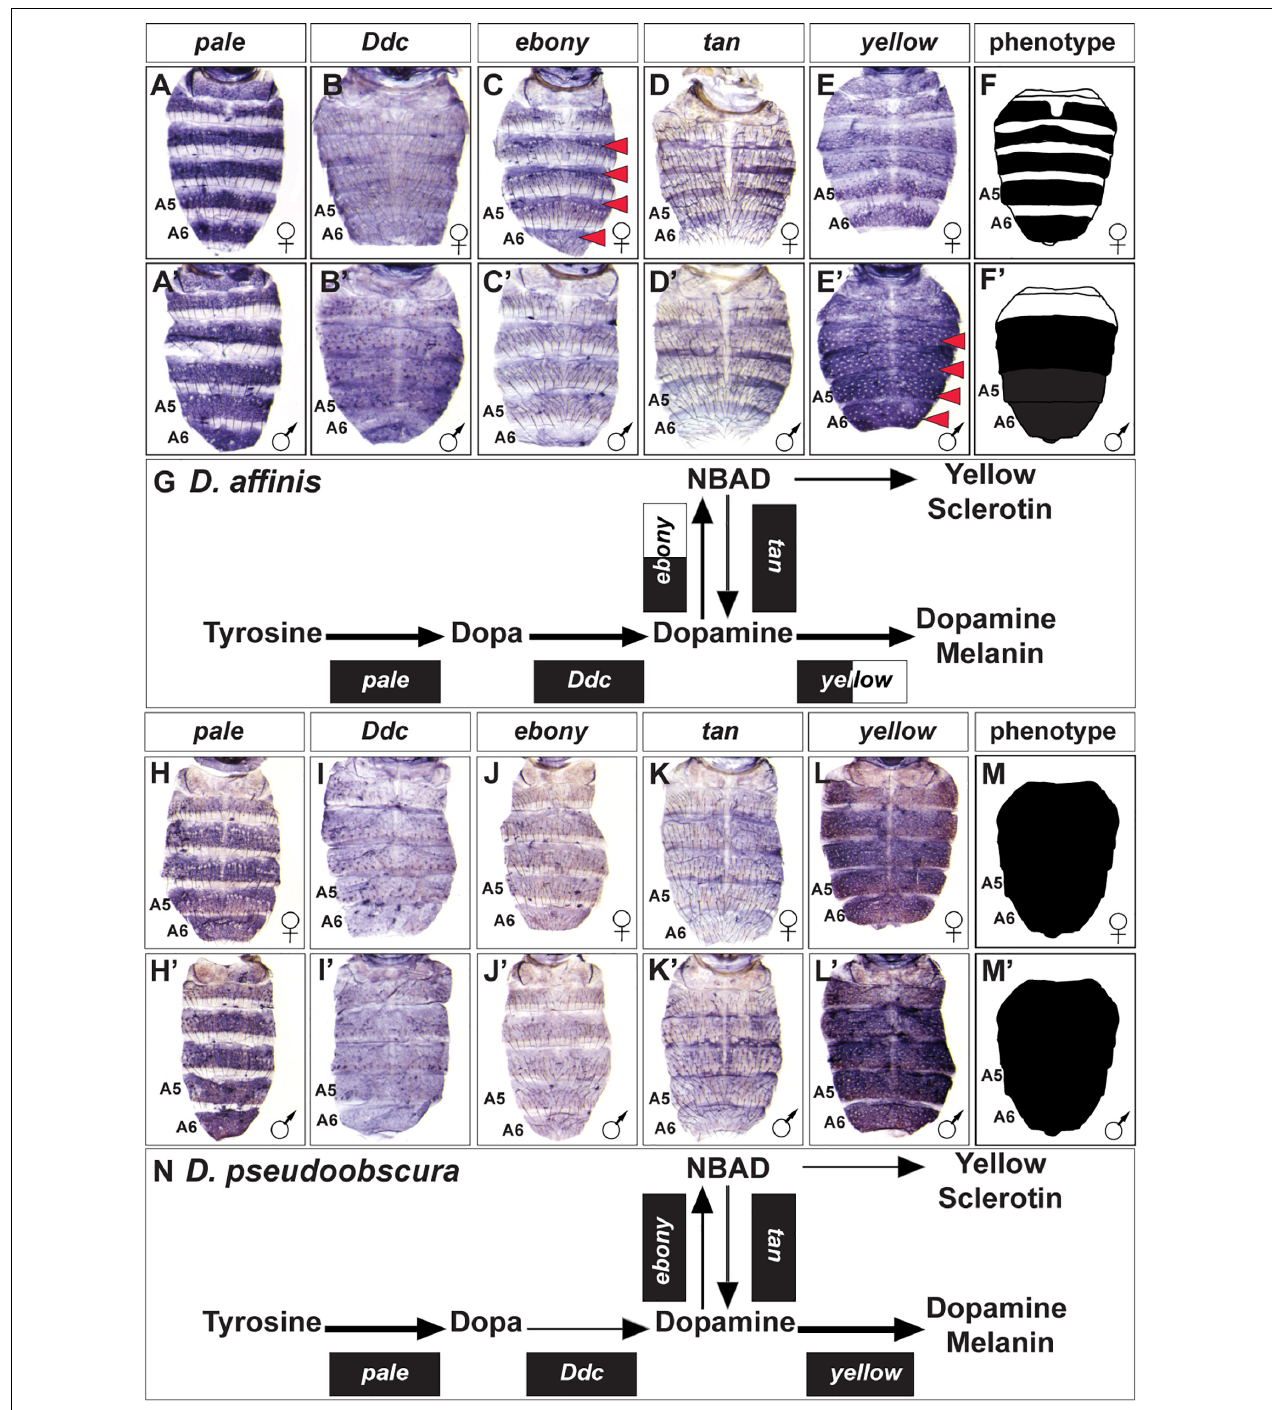
FIGURE 4 | Contrast in the pigment metabolic pathway utilization between the dimorphic D. affinis and the monomorphic D. pseudoobscura . (A–E) Female and (A’–E’) male expressions of D. affinis pigment metabolic pathway genes, and (F,F’) cartoon representation of the pigmentation phenotype. (G) Summary of the D. affinis pathway use includes robust expression of all genes, with dimorphic expressions of ebony , and yellow . (H–L) Female and (H’–L’) male expressions of D. pseudoobscura pigment metabolic pathway genes, and (M,M’) cartoon representation of the pigmentation phenotype. (N) Summary of the D. pseudoobscura pathway use includes monomorphic expression of all genes. (A,A’,H,H’) pale , (B,B’,I,I’) Ddc , (C,C’,J,J’) ebony , (D,D’,K,K’) tan , and (E,E’,L,L’) yellow . Red arrowheads indicate robust patterns of dimorphic expression in the A3-A6 segment epidermis. (G,N) Black arrow thickness represents the level of expression for the underlying gene. Monomorphic gene expression is represented by the gene names being placed upon a black rectangle. Dimorphic gene expression is represented by the gene names being placed upon a black and white colored rectangle.